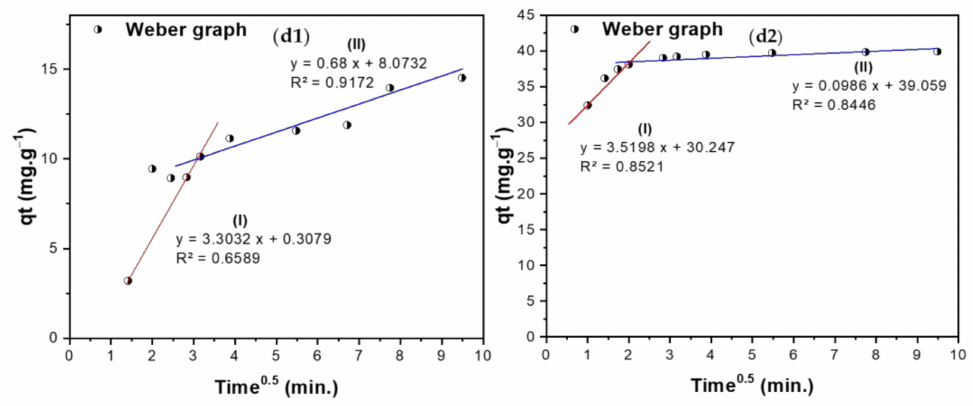
Figure 10. ( a1 , a2 ) Pseudo-first-order, ( b1 , b2 ) Pseudo-second-order, ( c1 , c2 ) Elovich, and ( d1 , d2 ) Intra-particle diffusion (WM) curves of adsorption of TIGC onto BCDP and